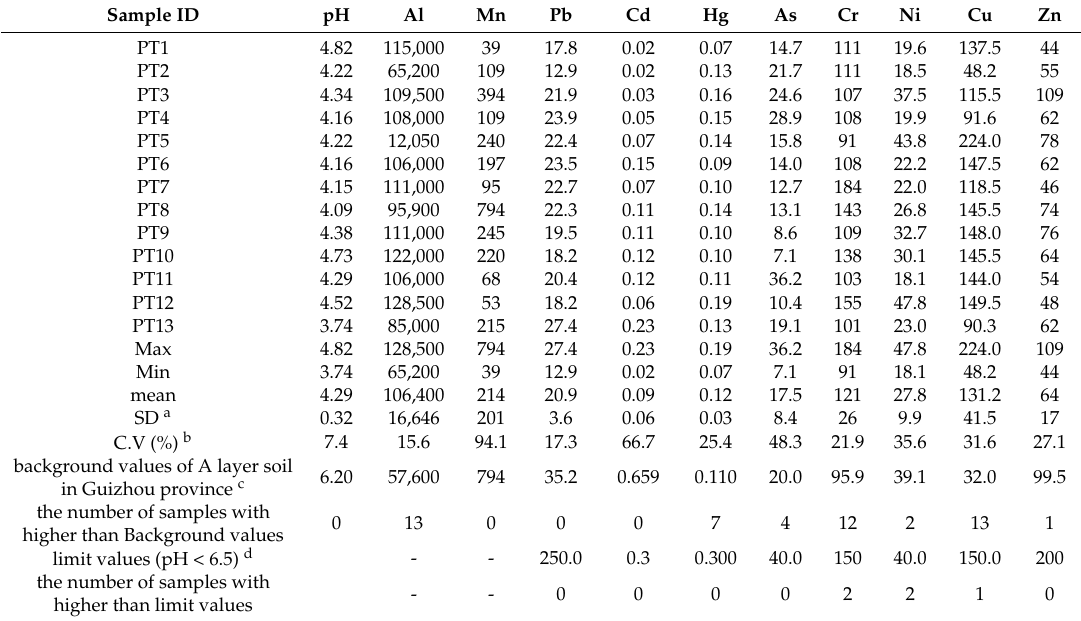
Table 1. Descriptive statistics of heavy metal concentrations (mg · kg − 1 ) in soil ( n = 13). a Standard deviation; b Coefficients of variation (%); c data was collected from Wei et al. [25]; d Grade II of Environmental Quality Standard for soil in China (GB 15618-1995)